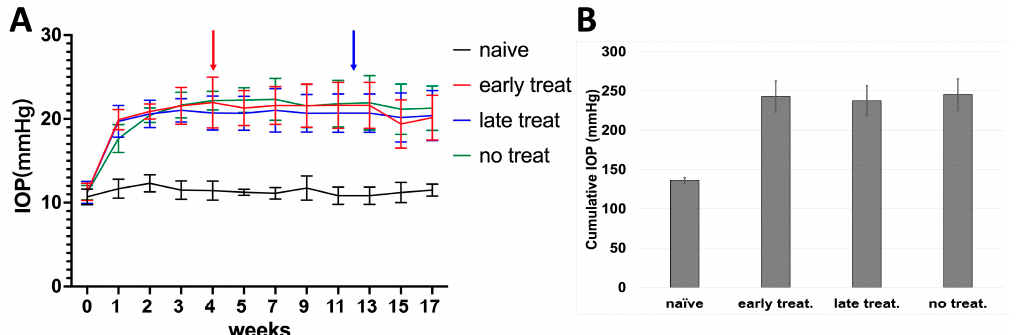
Figure 3. IOP in C57BL/6J mice following injection of Ad5myoc into the anterior chamber. ( A ) IOP profile of treatment groups. Pioglitazone treatment was initiated either 4 weeks (red arrow) or 12 weeks (blue arrow) after induction of elevated IOP. ( B ) Average cumulative IOP in treatment groups. No significant differences in cumulative IOP were observed between Ad5myoc-injected mice ( p > 0.25).